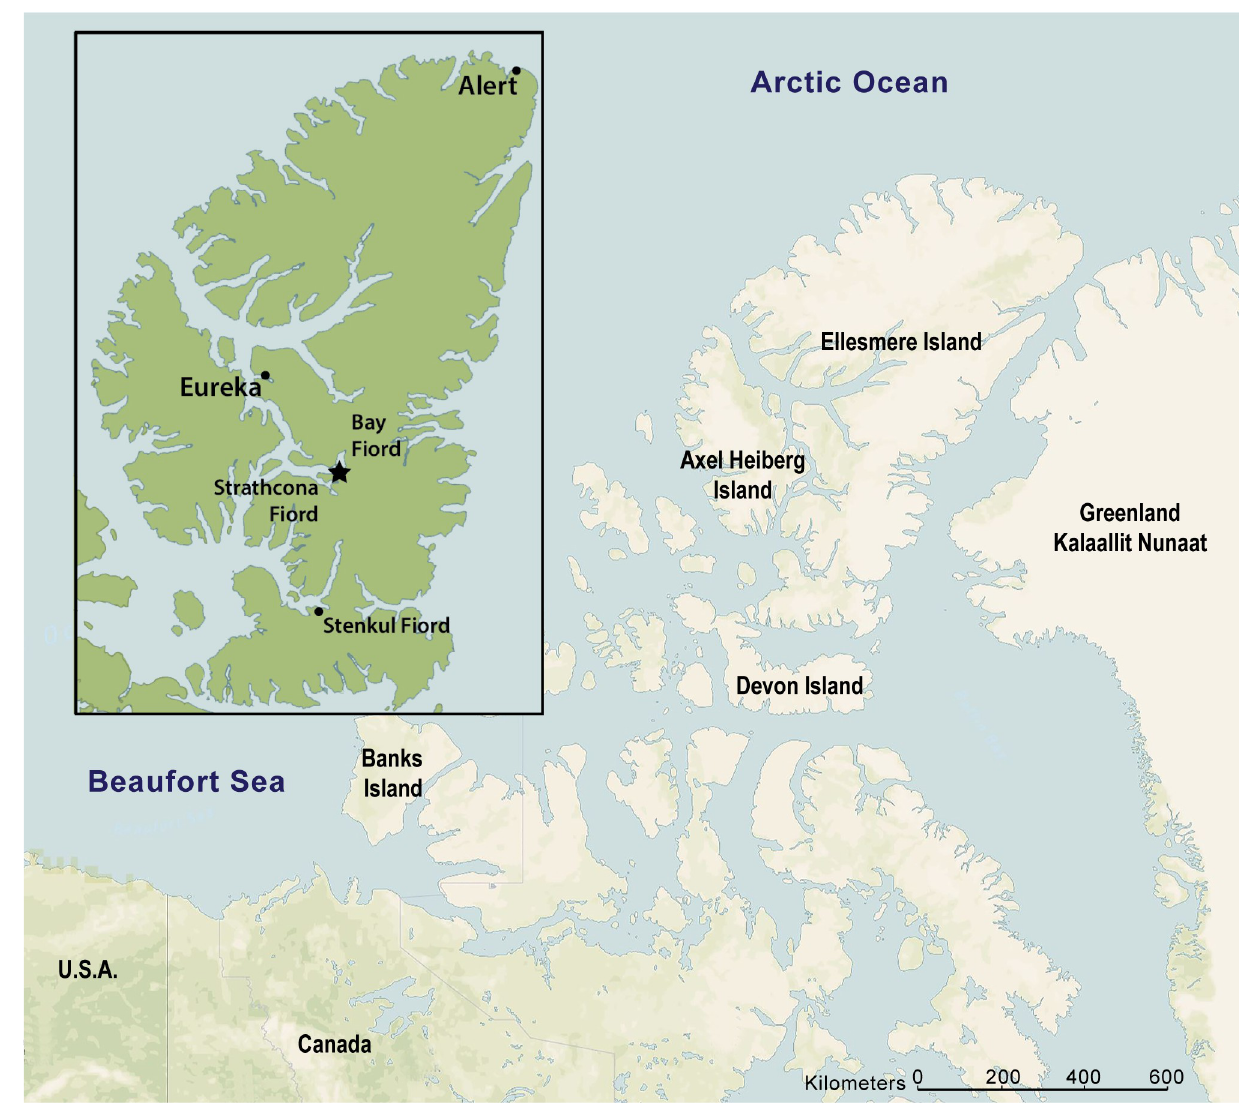
Fig 1. Map of Ellesmere Island, Nunavut, Canada and adjacent areas. The late early Eocene fossil sites yielding the paromomyid specimens described here are located on central Ellesmere Island near Bay Fiord (black star on enlarged map of Ellesmere shown as inset). Map adapted from public domain basemap available from U.S. Geological Survey